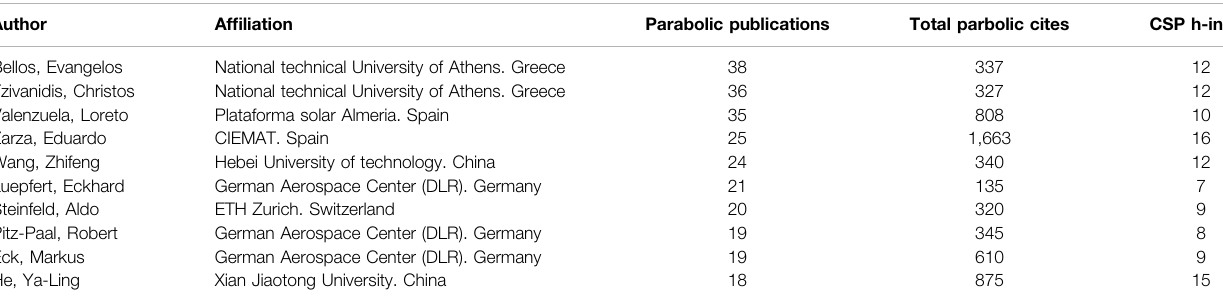
TABLE 8 | Top 10 authors in the Parabolic Trough fi